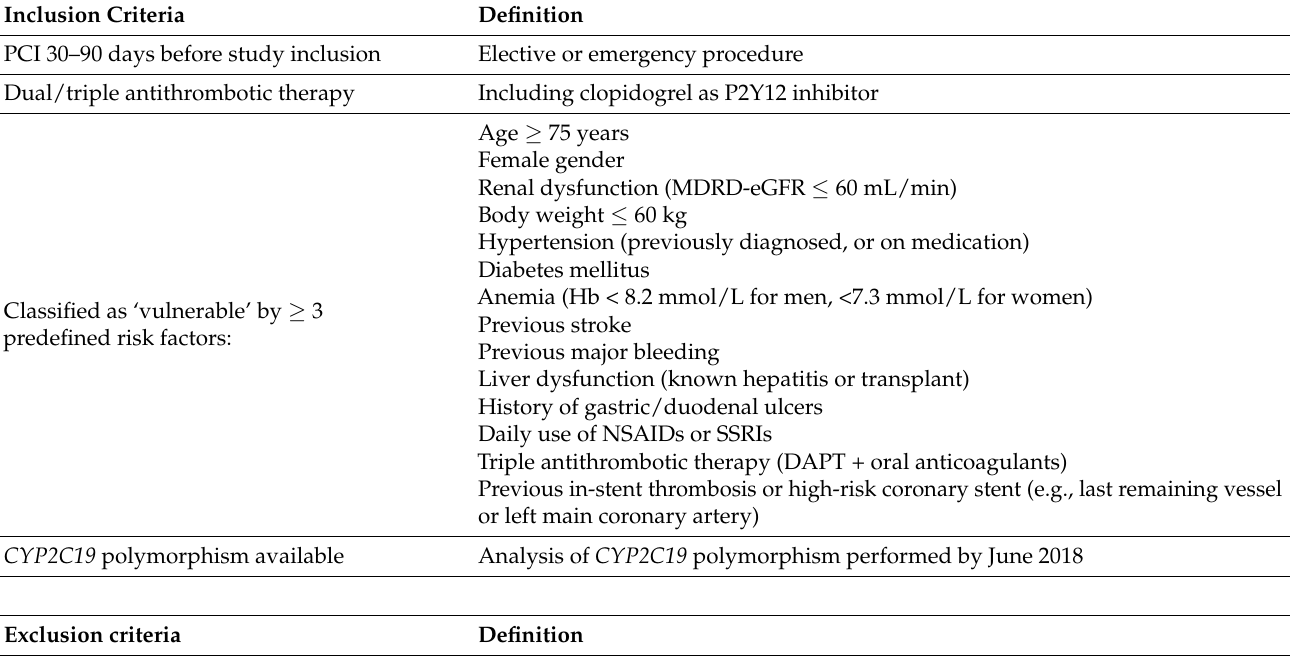
Table A1. Inclusion and exclusion